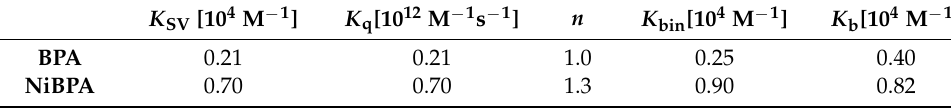
Figure 3. Fluorescence quenching spectra of BSA in the presence of an increasing concentration of ( a ) NiBPA and ( b ) BPA (inset are Stern − Volmer plots). Table 1. Binding constants of BSA to BPA and its nickel complex NiBPA